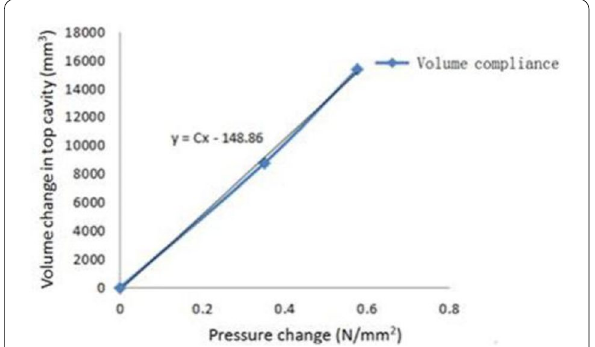
Figure 7 Volume compliance fitting curve